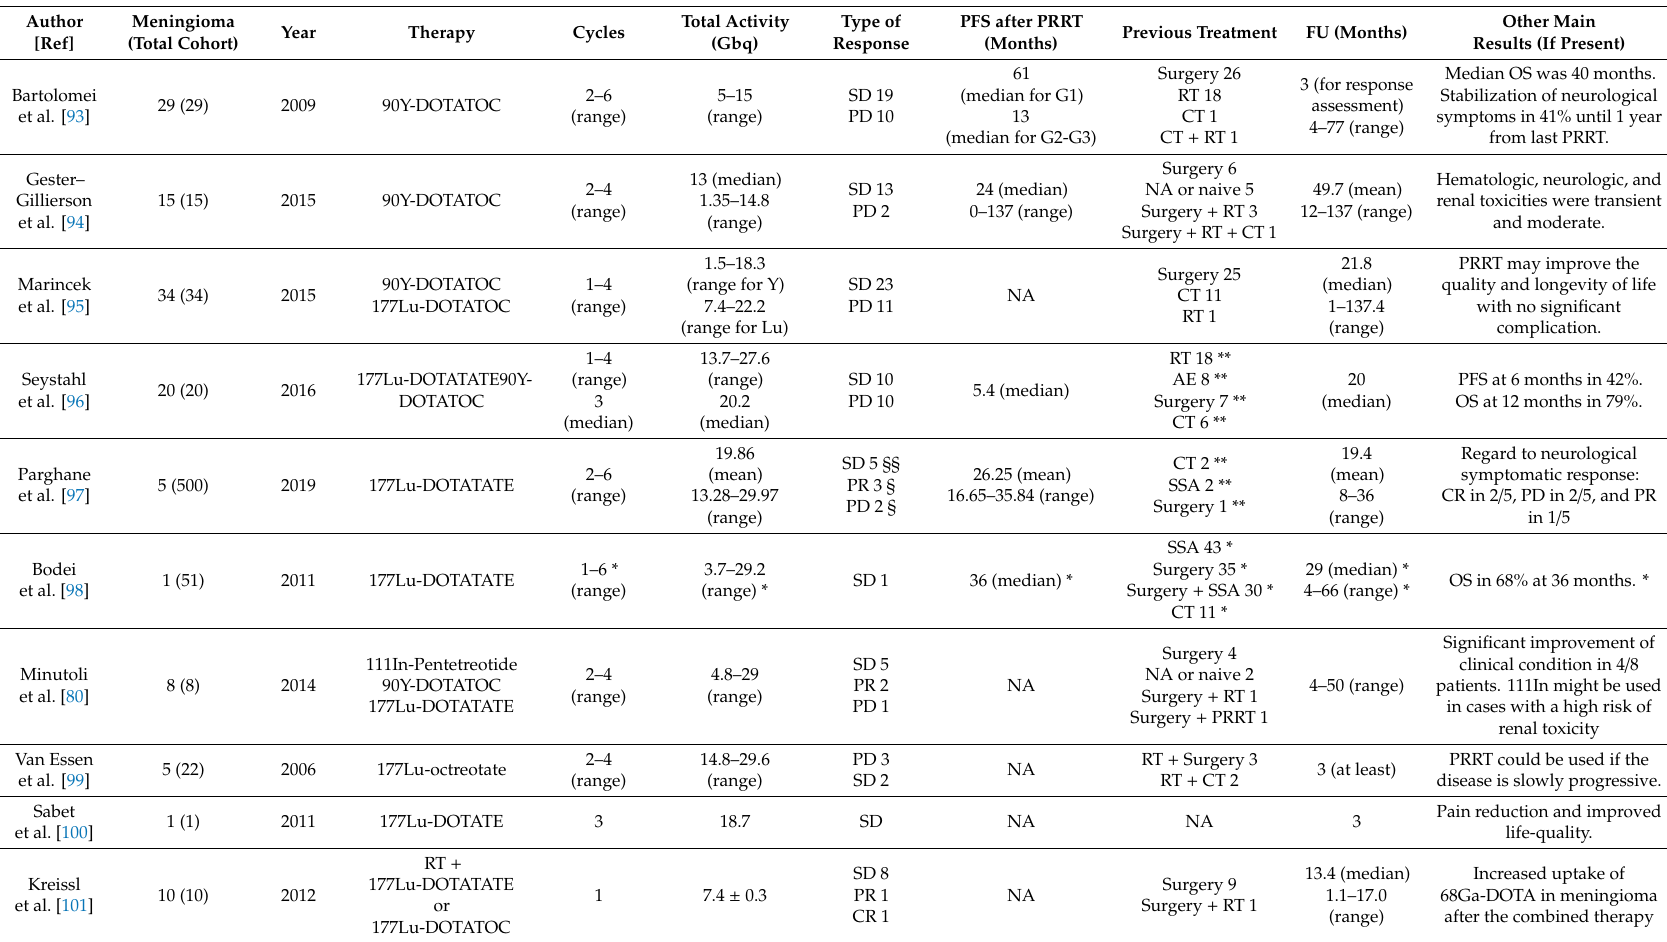
Table 2. Results of the Main Papers about PRRT in